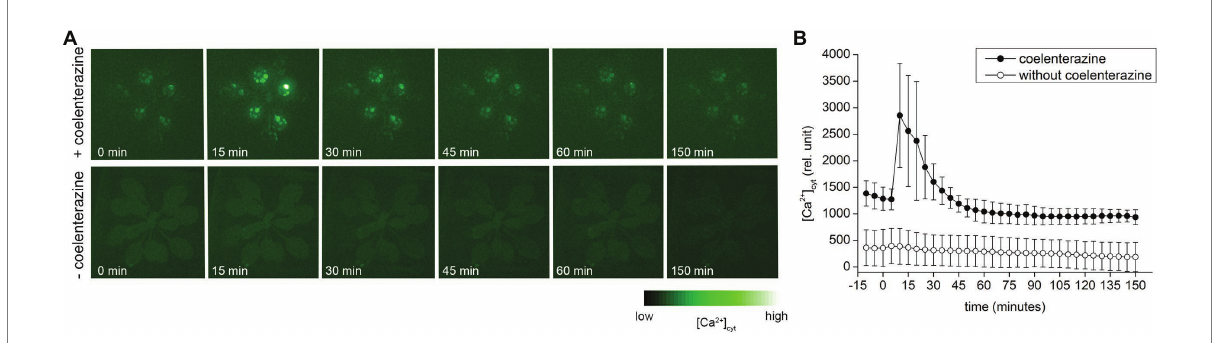
FIGURE 6 The cytoplasmic Ca 2+ [Ca 2+ ] cyt signals in whole Arabidopsis thaliana rosette expressing APOAEQUORIN in response to diethyl ether application. (A) Representative images of selected time points of plants treated (upper row) and non-treated (lower row) with coelenterazine. (B) Time course (0–250 min) of average [Ca 2+ ] cyt accumulation in whole rosette in response to diethyl ether application. Plants treated with coelenterazine (closed circles) or without it (open circles). The diethyl ether was applied at time point 1 min. Means ± SD, n = 4. The time lapse video of [Ca 2+ ] cyt is available as Supplementary Videos S1,